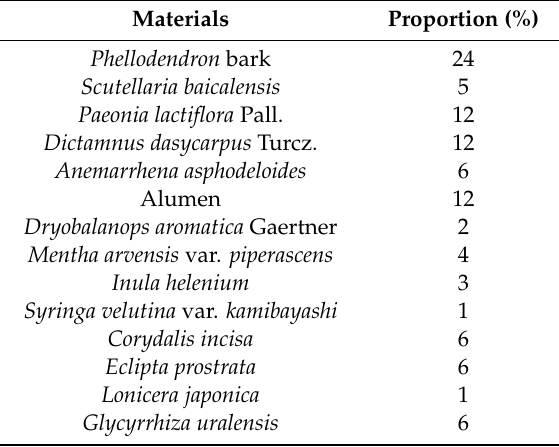
Table 1. Materials and proportion in ACC extracts.